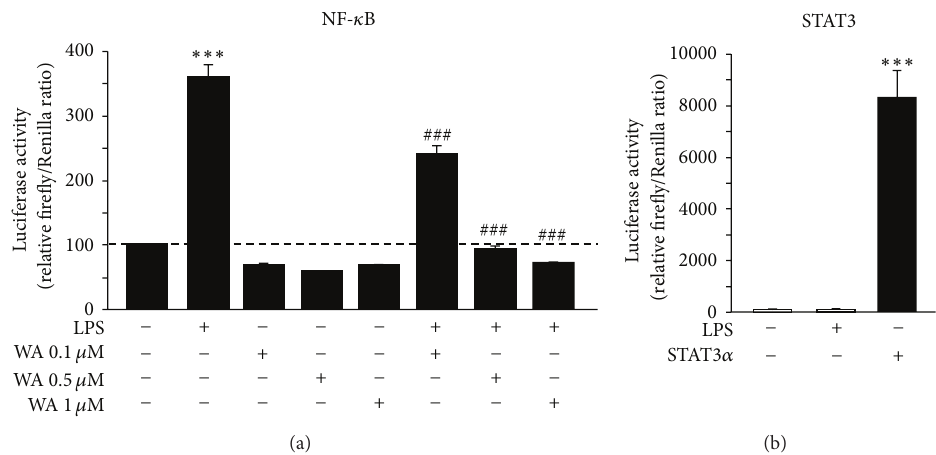
Figure 2: Impact of Withaferin A on LPS-induced NF- 𝜅 B activity in immortalized P0-17D cortical astrocytes. (a) P0-17D astrocytic cells were transiently co-transfected with the NF- 𝜅 B-RE- Luc transgene and the Renilla luciferase encoding plasmid, used as transfection control. Twenty-four hours after the transfection, cells were pre-treated for 1 hour with increasing concentrations of Withaferin A (WA) and then incubated in the presence or in the absence of 1 𝜇 g/mL LPS for additional 6 hours ( 𝑛 = 3 experiments in triplicate). Cell lysates were assayed for luciferase enzymatic activities, and firefly luciferase levels were normalized to Renilla luciferase values. Data (mean ± s.e.m.) are expressed as percentage of luciferase activity in control conditions, that is, the corresponding culture type challenged with saline ( ∗∗∗ 𝑝 < 0.0001 versus control, ### 𝑝 < 0.0001 versus LPS; one-way ANOVA followed by Bonferroni post hoc test). (b) P0-17D astrocytes were transiently co-transfected with STAT3-driven firefly luciferase and Renilla luciferase reporter vectors in the absence or in the presence of a plasmid encoding the constitutively active STAT3 𝛼 protein. Cells were subsequently incubated with or without 1 𝜇 g/mL LPS for 6 hours ( 𝑛 = 3 experiments in triplicate) and cell lysates were assayed for luciferase enzymatic activities, as above. Data (mean ± s.e.m.) are expressed as percentage of luciferase activity in control conditions, that is, the corresponding culture type challenged with saline ( ∗∗∗ 𝑝 < 0.0001 versus control; one-way ANOVA followed by Bonferroni post hoc